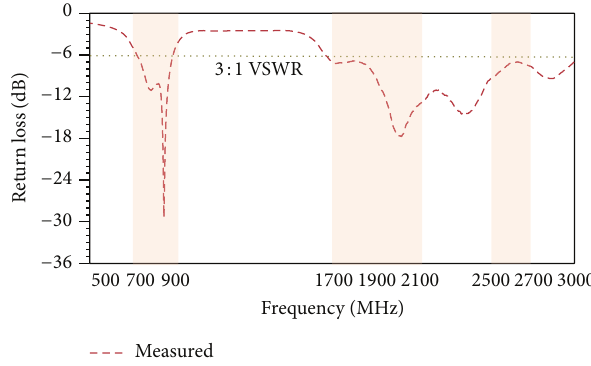
Figure 6: Measured VSWR of the proposed antenna at V 0